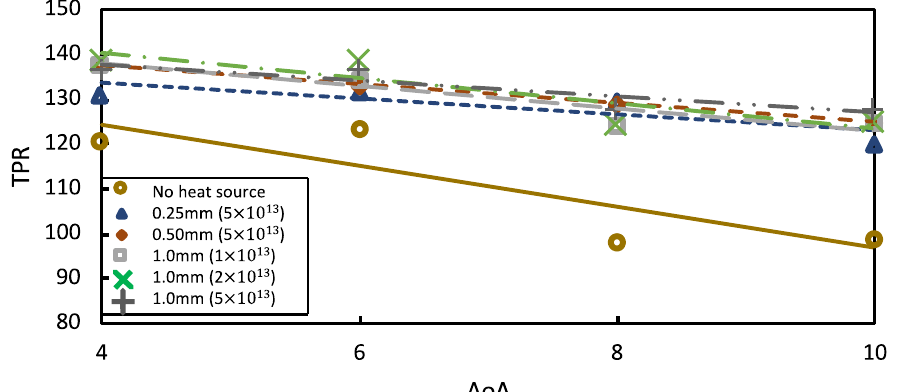
Figure 9. Total pressure recovery in steady-state condition at various diameters and powers of heat source.